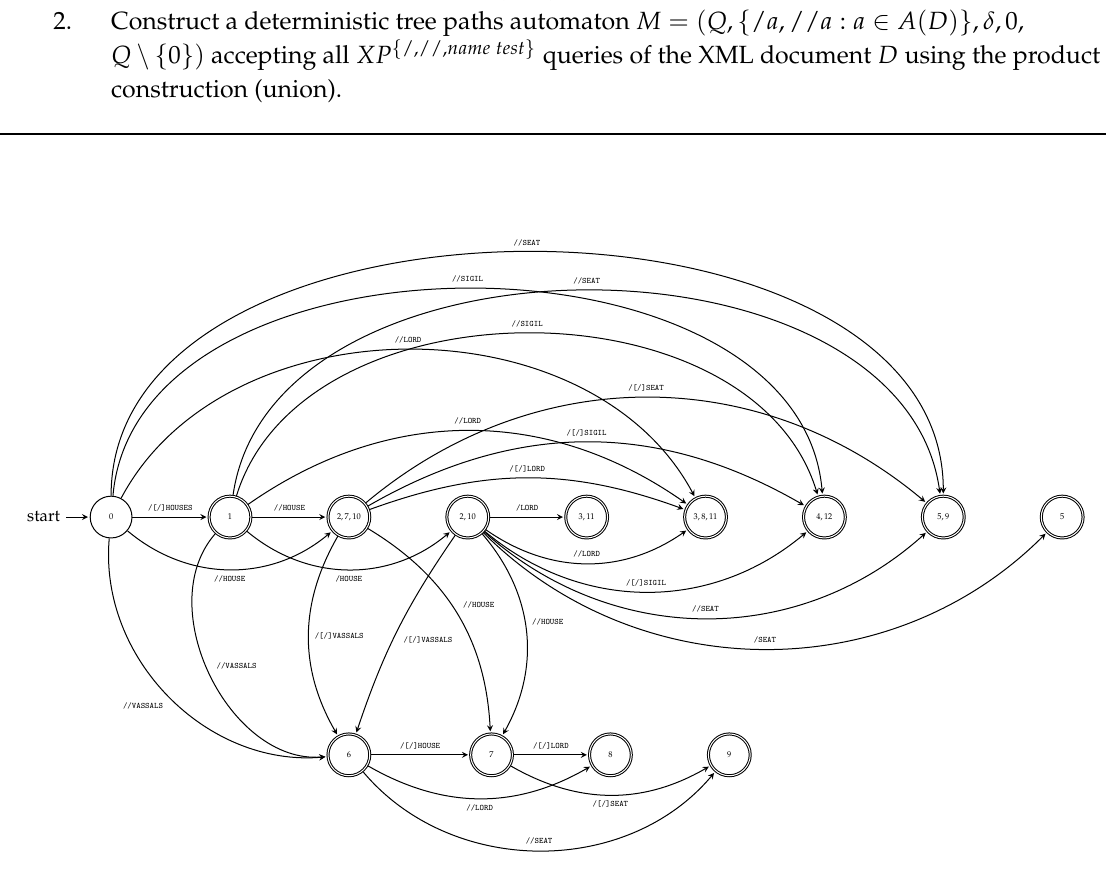
Figure 9. Deterministic tree paths automaton from Example